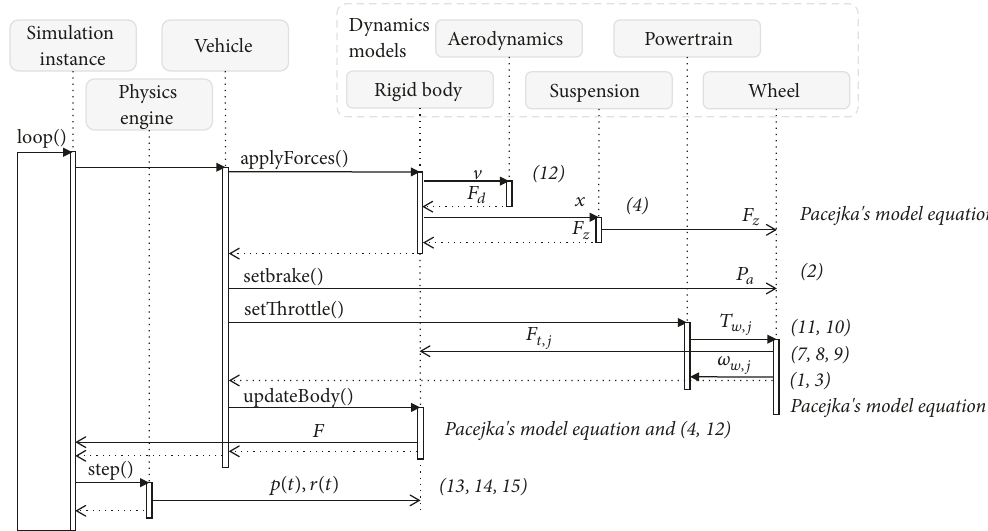
Figure 11: Calculation sequence of simulation